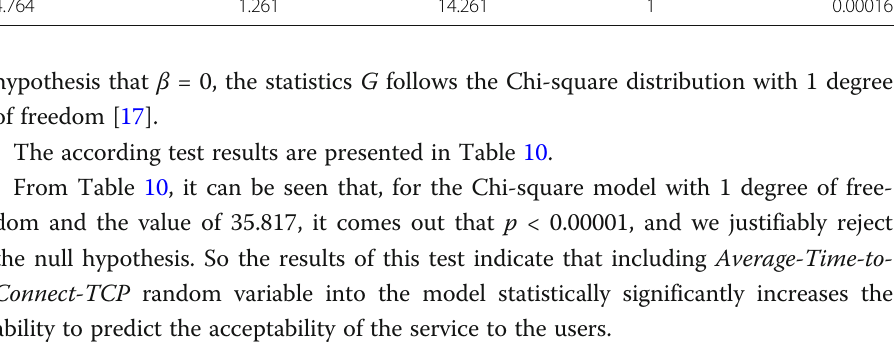
Table 5 Estimated logistic regression intercept and its properties Intercept α